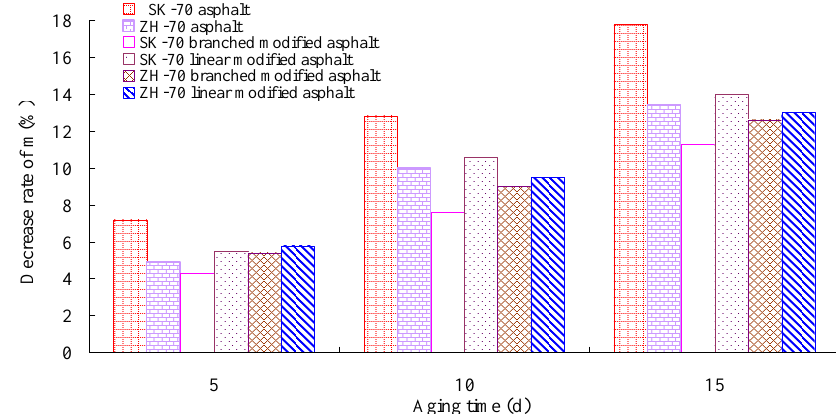
Figure 8. Creep stiffness change rate and aging time.